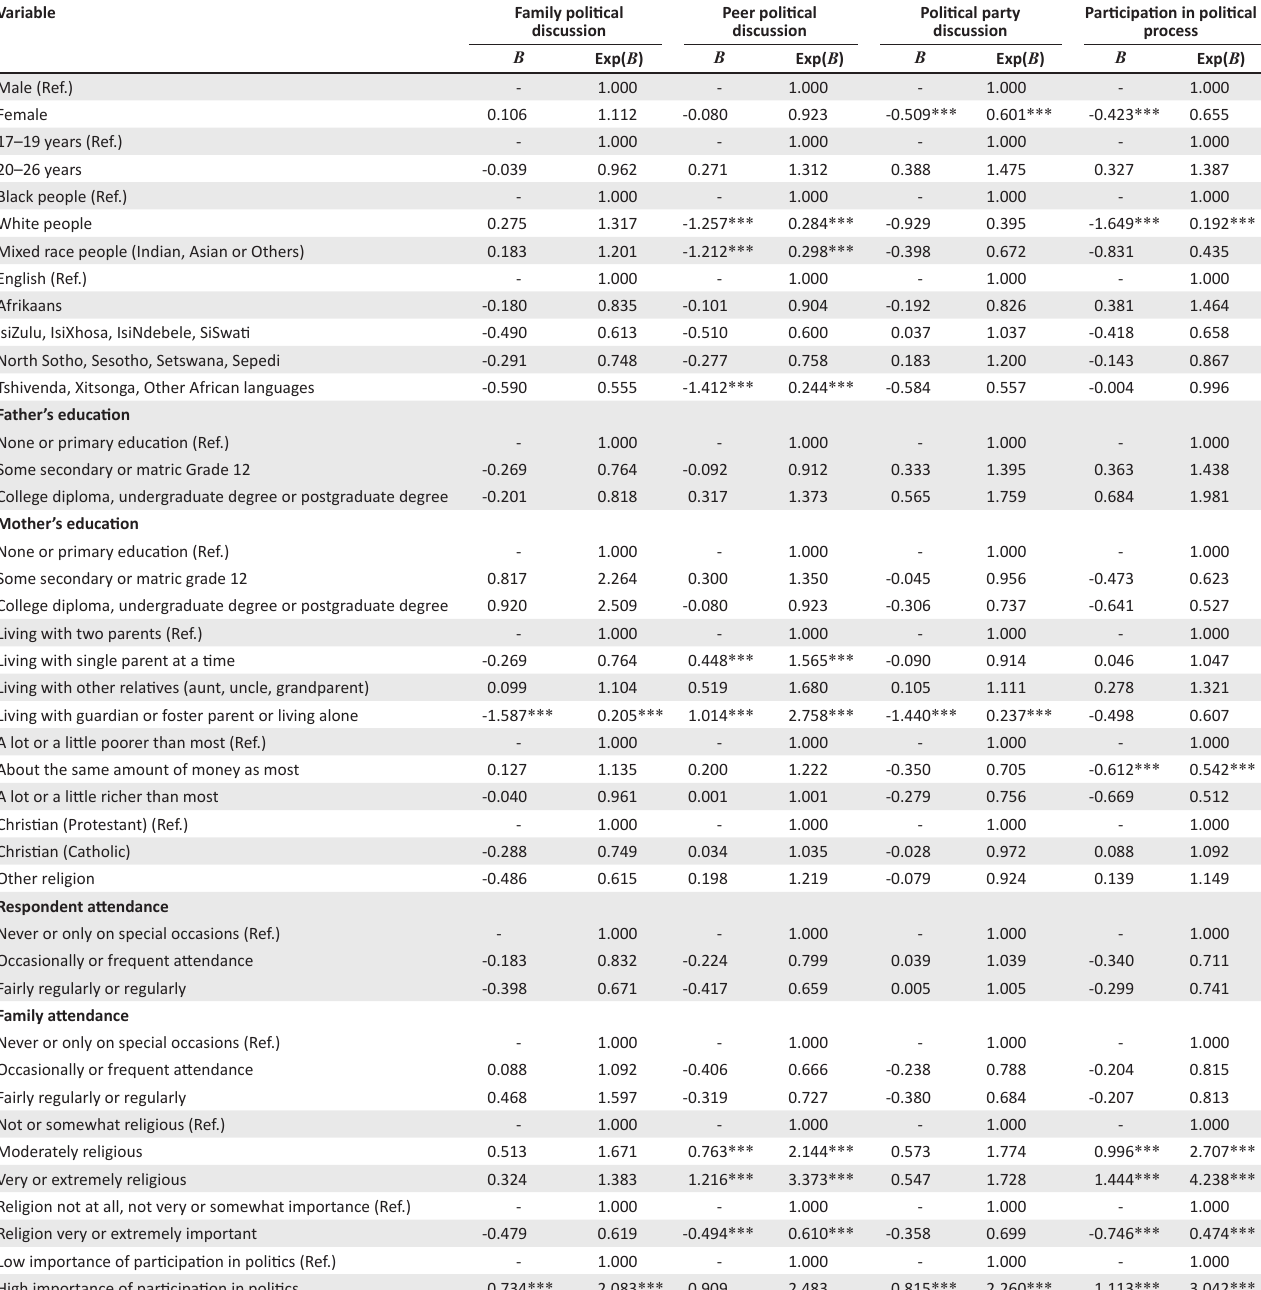
TABLE 4: Logit model of religion effects on youth political engagement.